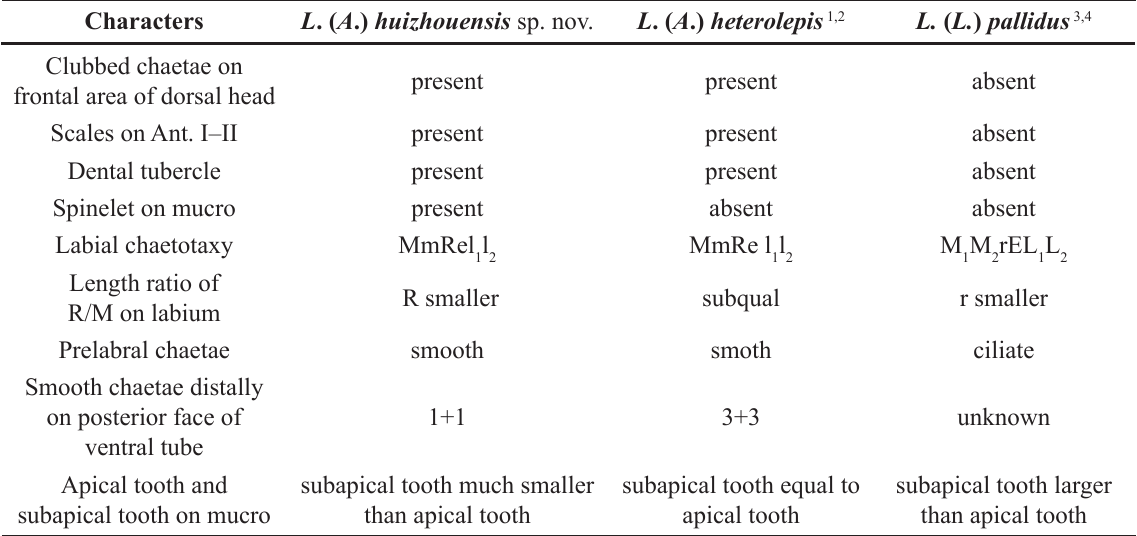
Table 2. Comparison of Lepidocyrtus ( Acrocyrtus ) huizhouensis sp. nov., L . ( A .) heterolepis Yosii, 1959 and L. ( Lanocyrtus ) pallidus Reuter,